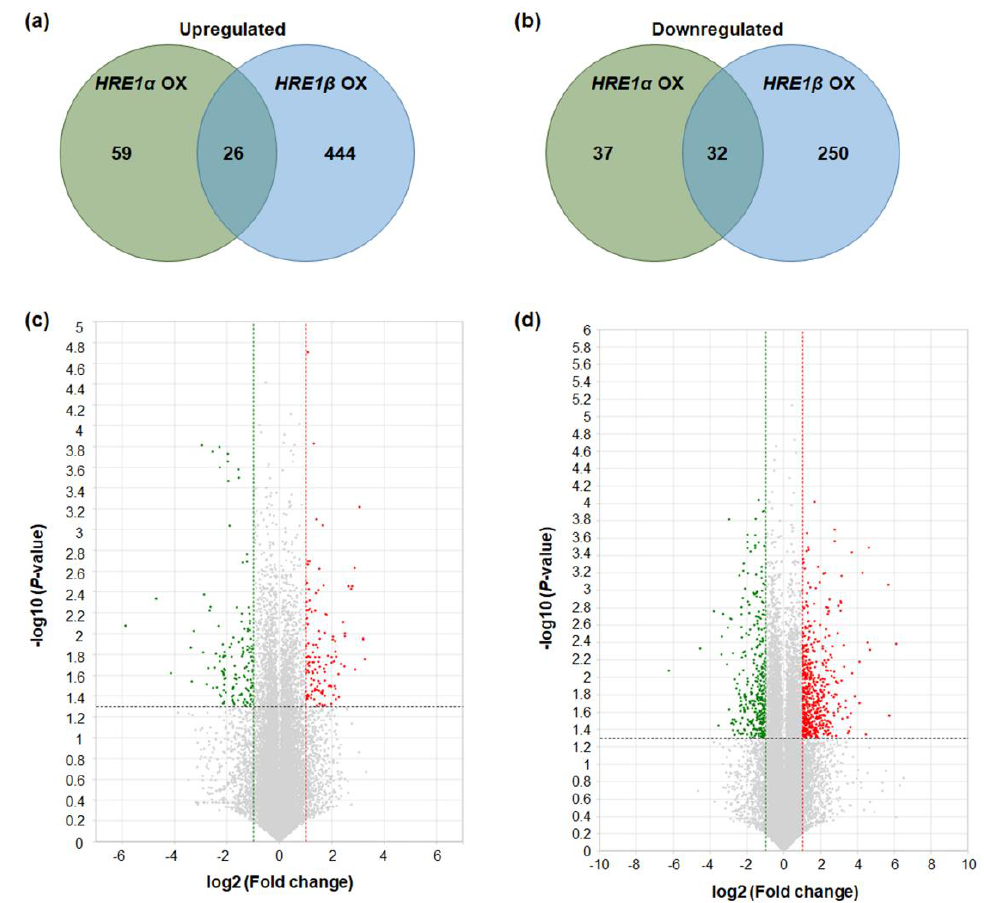
Figure 9. Differentially expressed genes in HRE1α OXs and/or HRE1β OXs. ( a ) The numbers of genes that were upregulated in HRE1α OXs and/or HRE1β OXs relative to those in WT plants with >2-fold differences in expression and a p < 0.05. ( b ) The numbers of genes that were downregulated in HRE1α OXs and/or HRE1β OXs relative to those in WT plants with >2-fold differences in expression and a p < 0.05. ( c ) Volcano plot of DEGs identified between WT and HRE1α OXs. ( d ) Volcano plot of DEGs identified between WT and HRE1 β OXs. In ( c ) and ( d ), DEGs were selected by p < 0.05 and log2 ratio ≥ 1